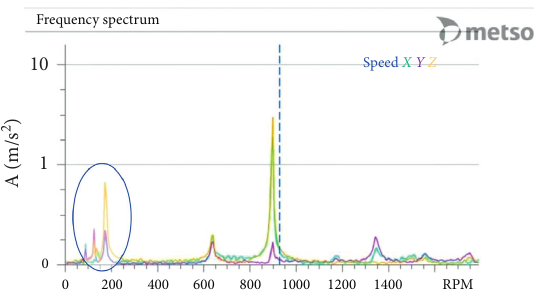
Figure 15: Natural frequencies identified by the bump test in ScreenCheck system